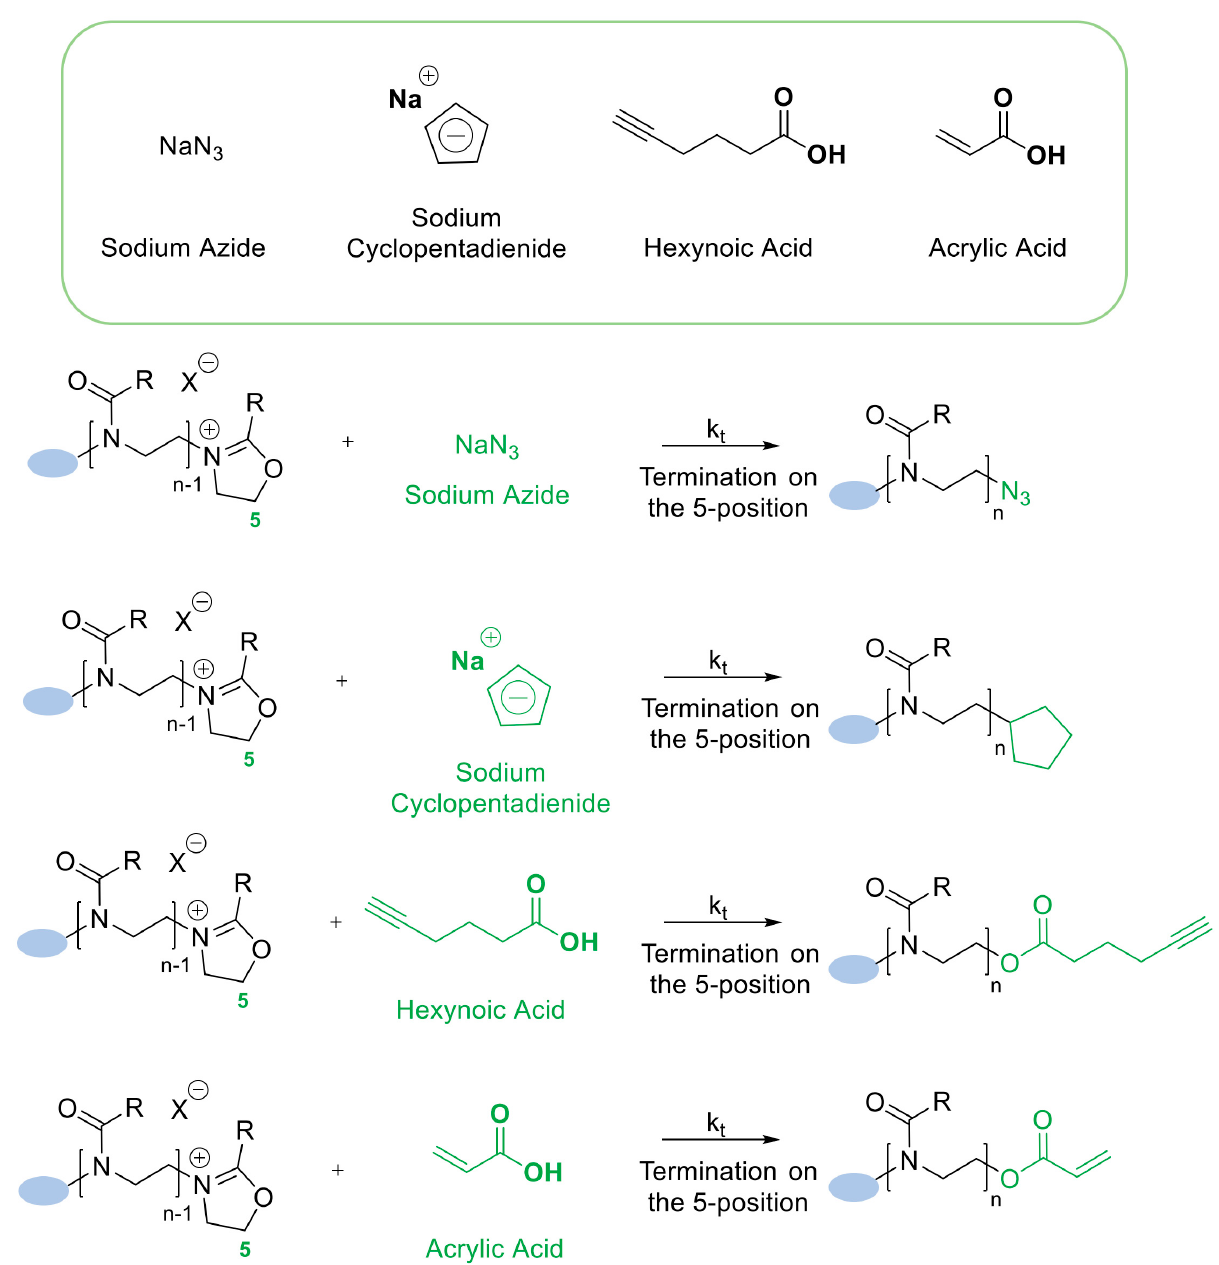
Figure 8. An overview of the chemical structures of end-functionalities that may be introduced by the termination step of CROP and the general termination mechanism with using these terminating agents.